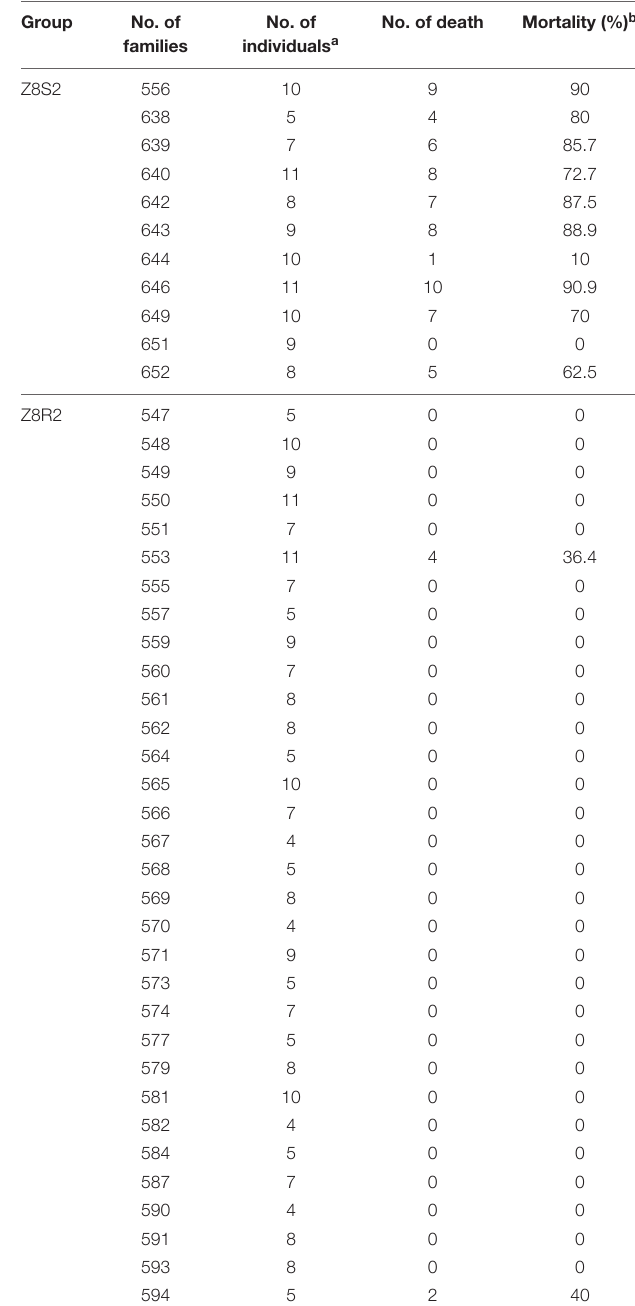
a Excluding ducklings used for sample collection. b No. of death/no. of individuals inoculated.